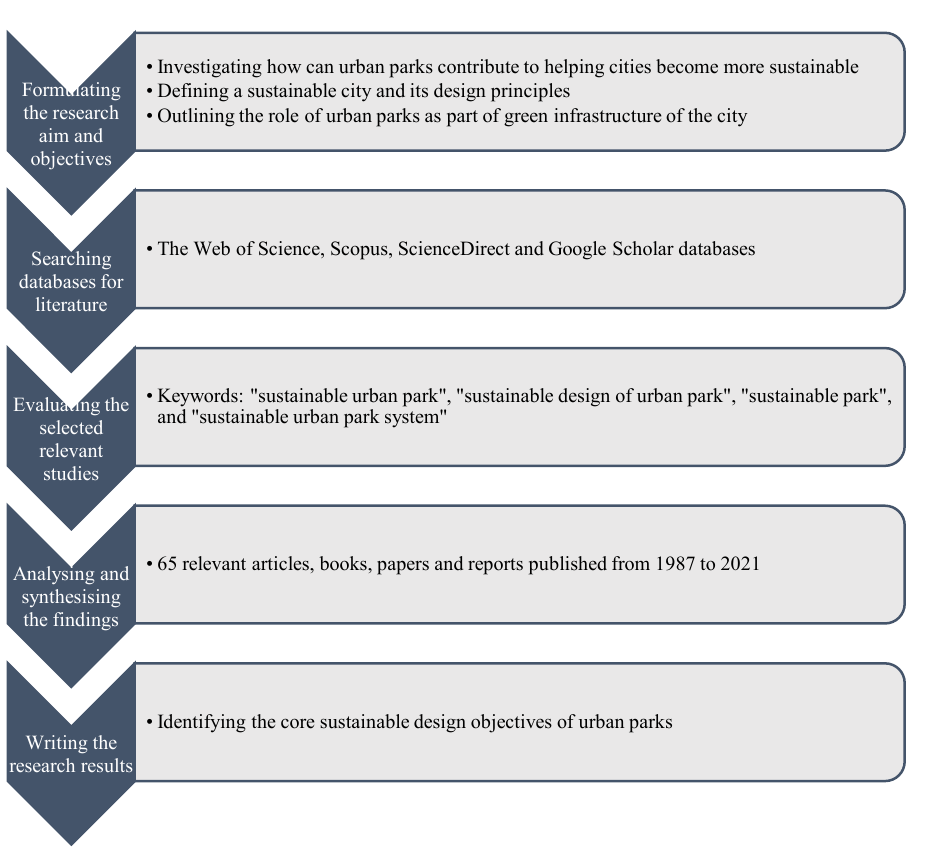
Figure 1. Methodology of the